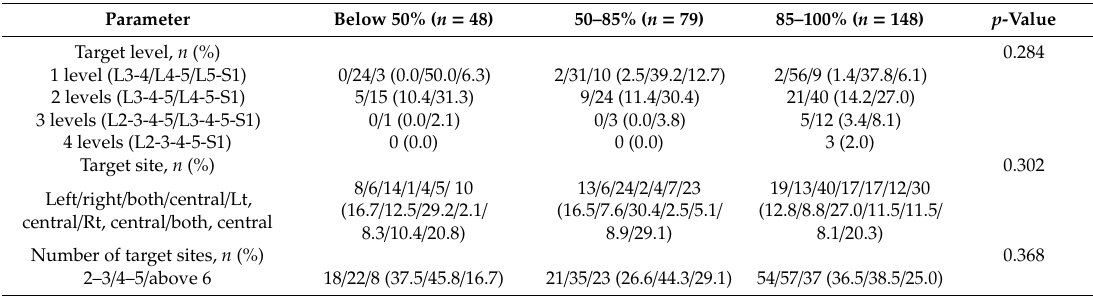
Table 2. Intervention characteristics of the study subjects according to the success rate of balloon adhesiolysis for multiple